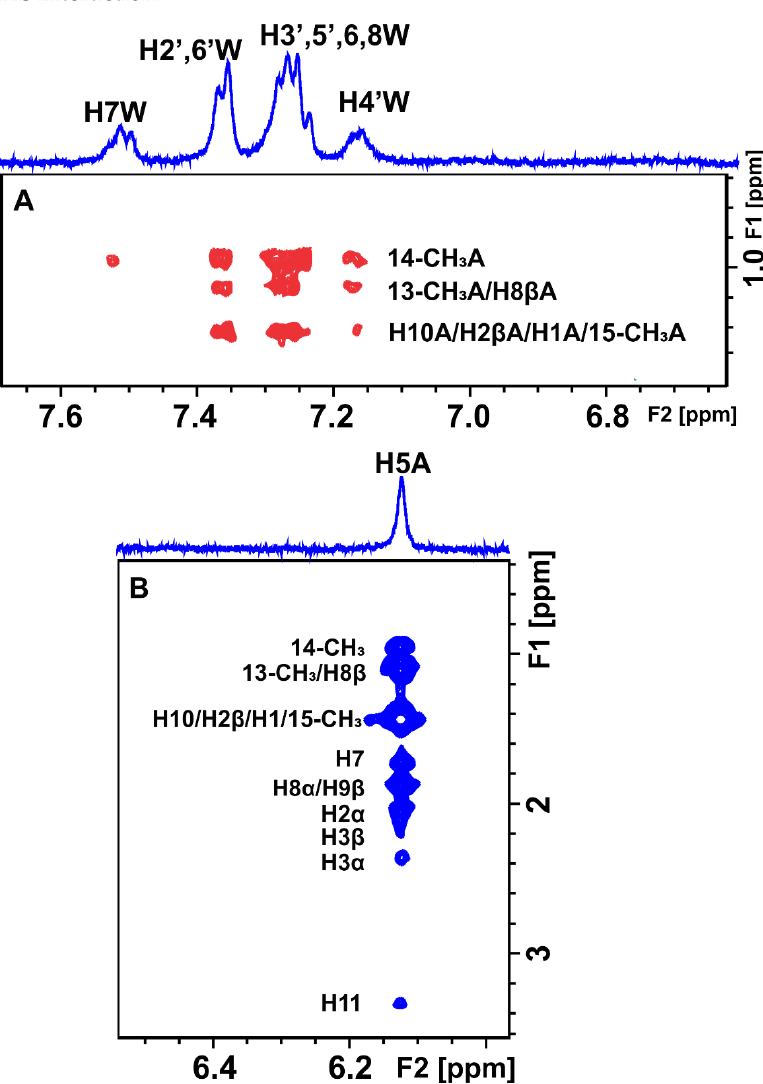
Figure 7. Selective region of the 2D Tr-NOESY NMR spectrum (d8 = 300 ms) of 2 mM artemisinin and 20 μΜ BSA after the addition of 2 mM warfarin in PBS buffer solution in D 2 O, pD 7.4 with 10% DMSO-d 6 . ( A ) Red cross-peaks correspond to inter-NOEs between warfarin and artemisinin and ( B ) blue cross-peaks correspond to intra-NOEs of artemisinin. NMR parameters are the same as in Fig- ure 3.